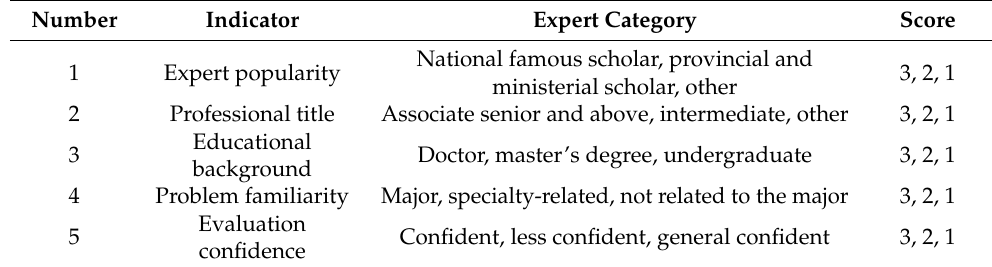
Table 2. Expert weight coefficient score